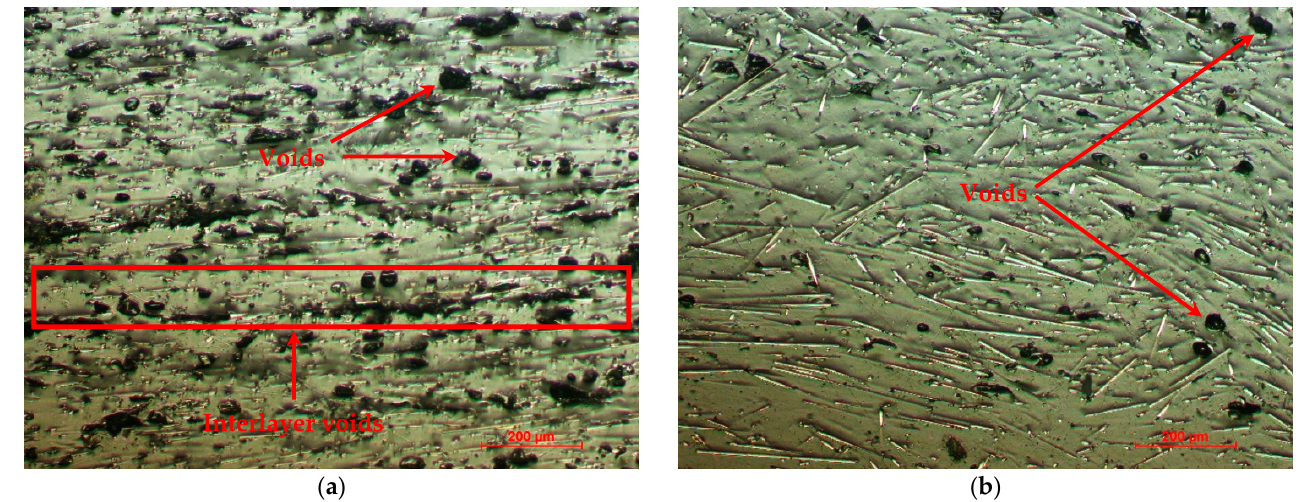
Figure 11. Microscopic analysis of the landing gear manufactured of PAHT CF15: ( a ) longitudinal section (100×); ( b ) cross-section (100×).